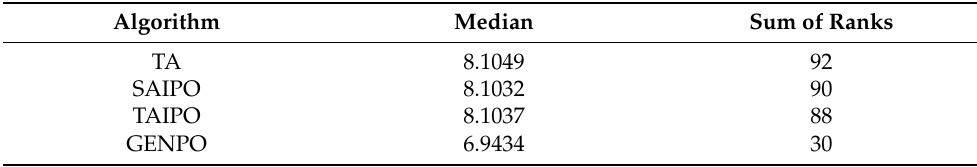
Table 10. Friedman Test for best algorithms without MARR constraint.